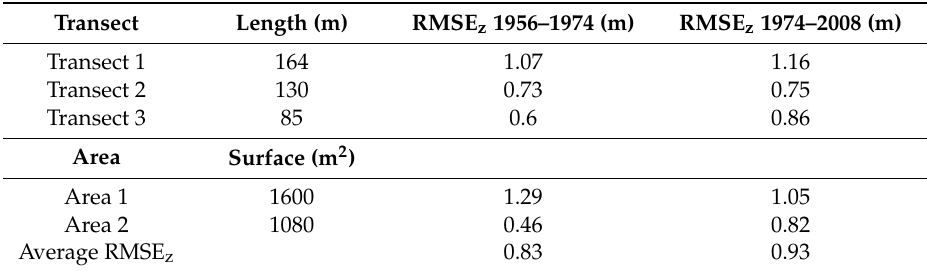
Table 1. Elevation differences calculated along the selected transect/area and resulting minLoD values.